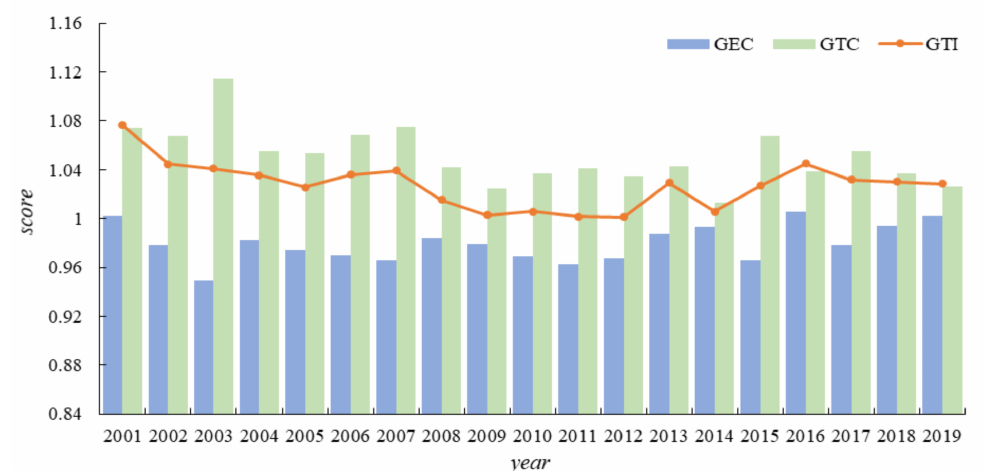
Figure 1. GTI and its decomposition, 2001–2019.